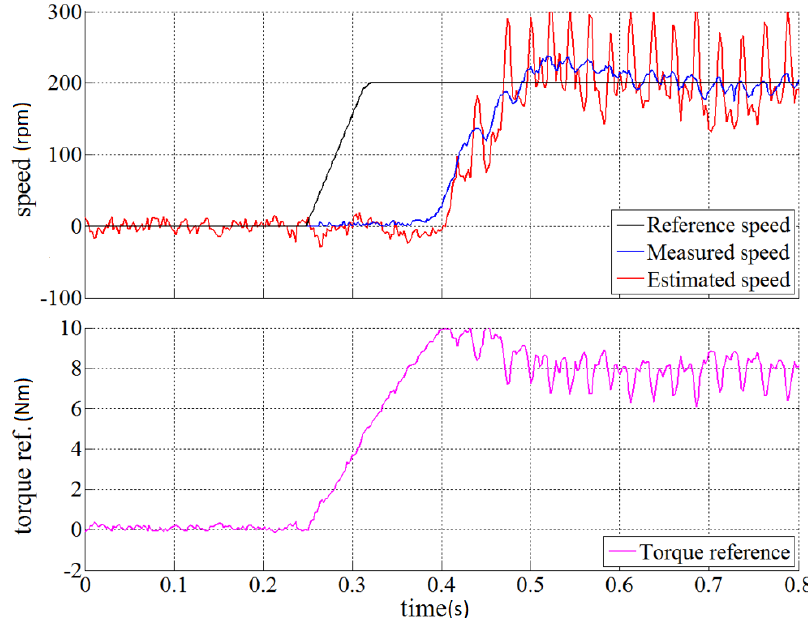
Figure 22. Motor #1: Increased bandwidth sensorless speed control (MTPA), startup from 0 to 200 rpm, proposed (self-adaptation) rotating voltage injection and i i1 regulation (150 mA), 6 Nm load.